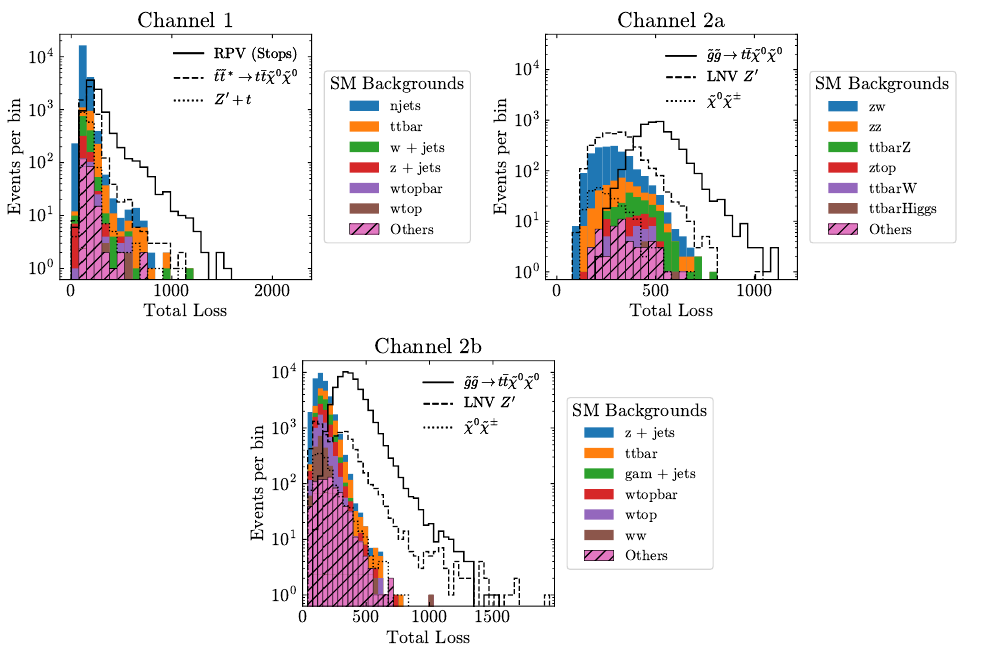
Figure 4: Anomaly score for the networks using β = 10 − 3 and w = 10.0. The value of β determines the ratio of contributions to the loss coming from the set reconstruction and the latent space representation and w controls the relative importance of the four-vector recon- struction versus the particle identification. The networks are trained on SM background events and then applied to a new set of background and BSM events. The background histograms are stacked, while the BSM signals are independently overlaid. Even though the number of dominant background changes for each channel, the same network architecture can be applied to each to separate some signals from the